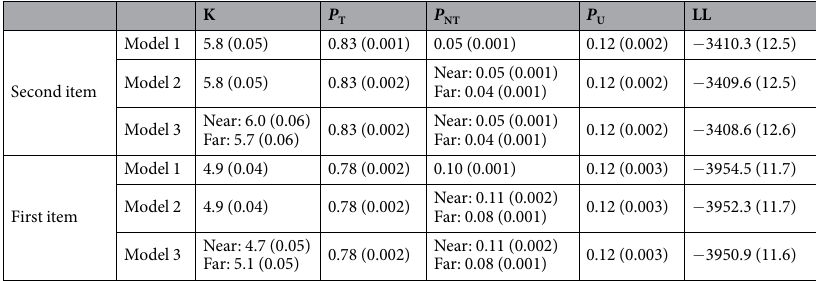
Table 5. Estimates from the mixture models for Experiment 4, calculated using a model in which neither K nor P NT could differ between Near and Far conditions (Model 1), a model in which only P NT could differ (Model 2) and a model in which both K and P NT could differ (Model 3). The 95% confidence interval is shown in parentheses, which was found by bootstrapping the data 100 times. LL denotes the log